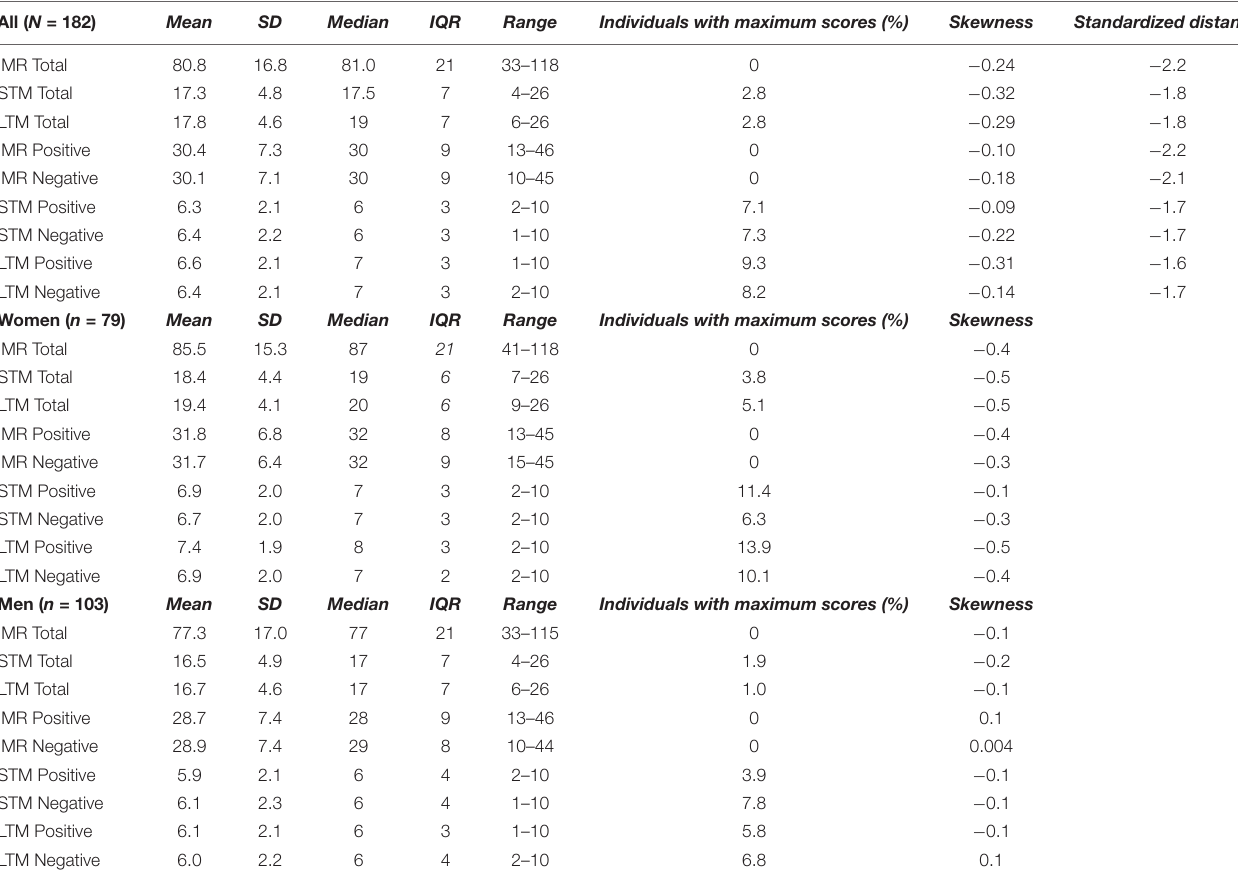
TABLE 2 | Descriptive information on VAMT-26